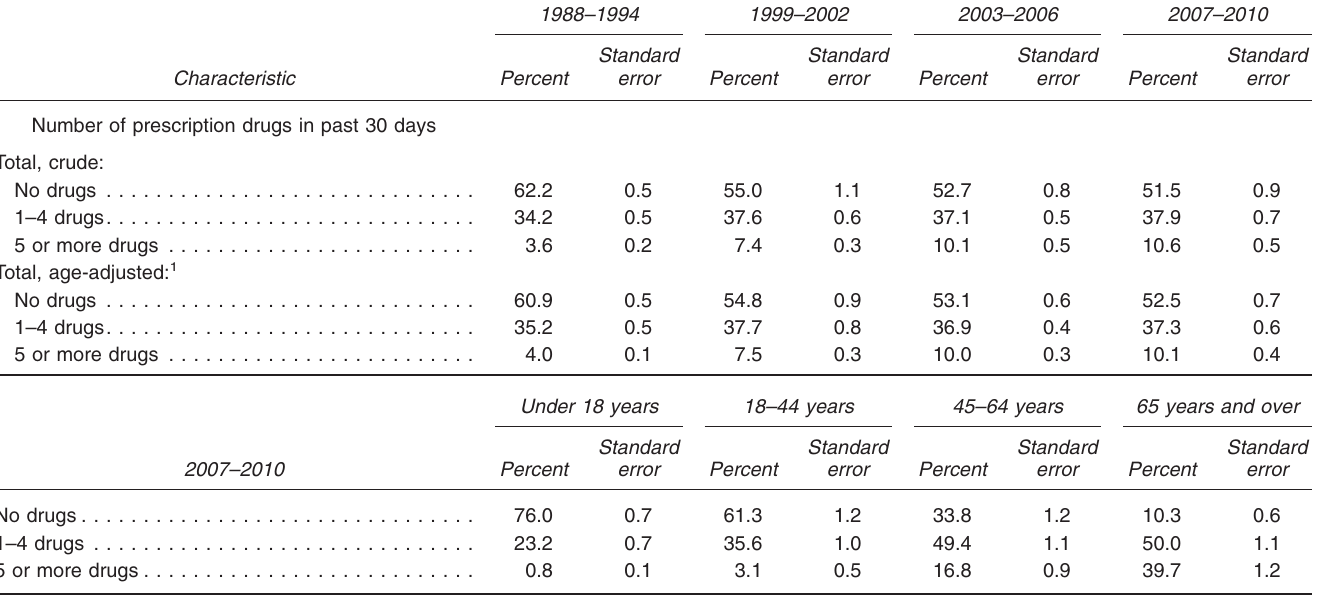
Data table for Figure 20. Prescription drug use in the past 30 days, by number of drugs taken and age: United States, 1988–1994 through 2007–2010 Excel and PowerPoint: